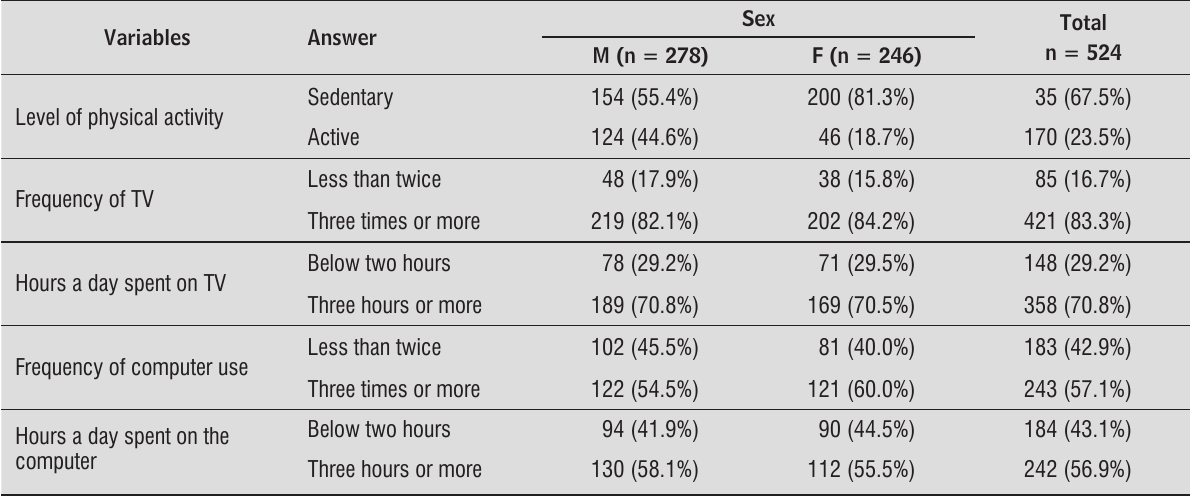
Table 1 - Distribution of absolute and relative frequencies of sedentary activities and level of physical activity according to sex, Bauru -